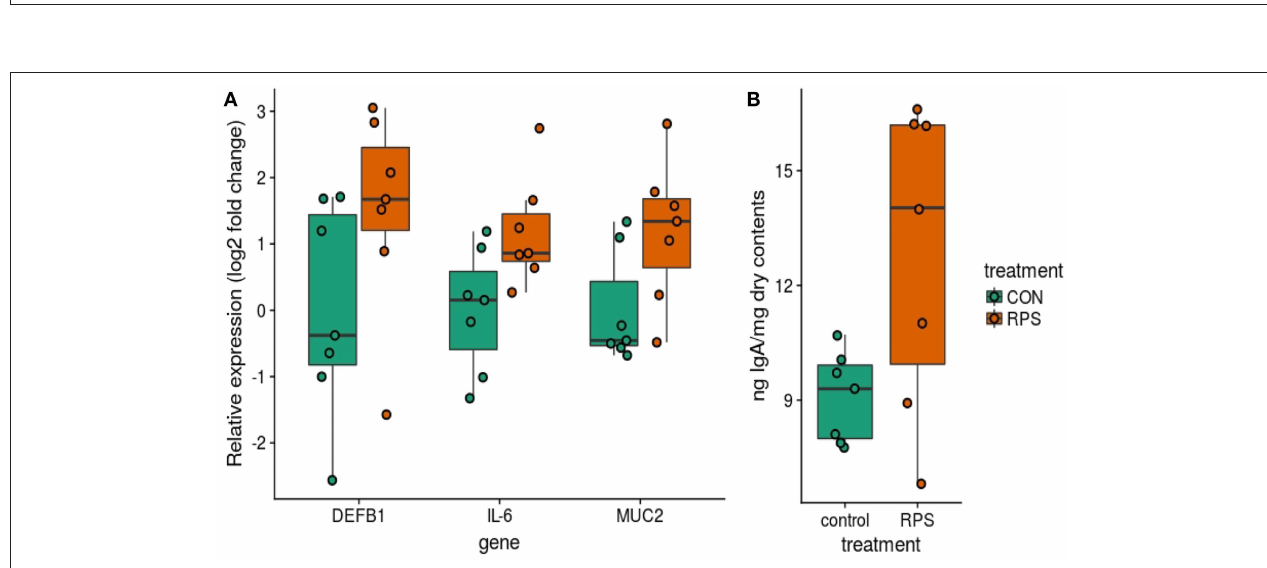
FIGURE 7 | Differences in host traits associated with mucosal barrier function between CON and RPS-fed animals. (A) mRNA expression of barrier function-associated genes from the cecal mucosa. (B) Amount of IgA in cecal contents. Wilcoxon p- values: DEFB1 p = 0.16, IL-6 p = 0.04, MUC2 p = 0.04, IgA p = 0.1. DEFB1 = beta defensin 1, IL-6 = Interleukin 6 gene, MUC2 = mucin 2 gene. IgA = Immunoglobulin A.